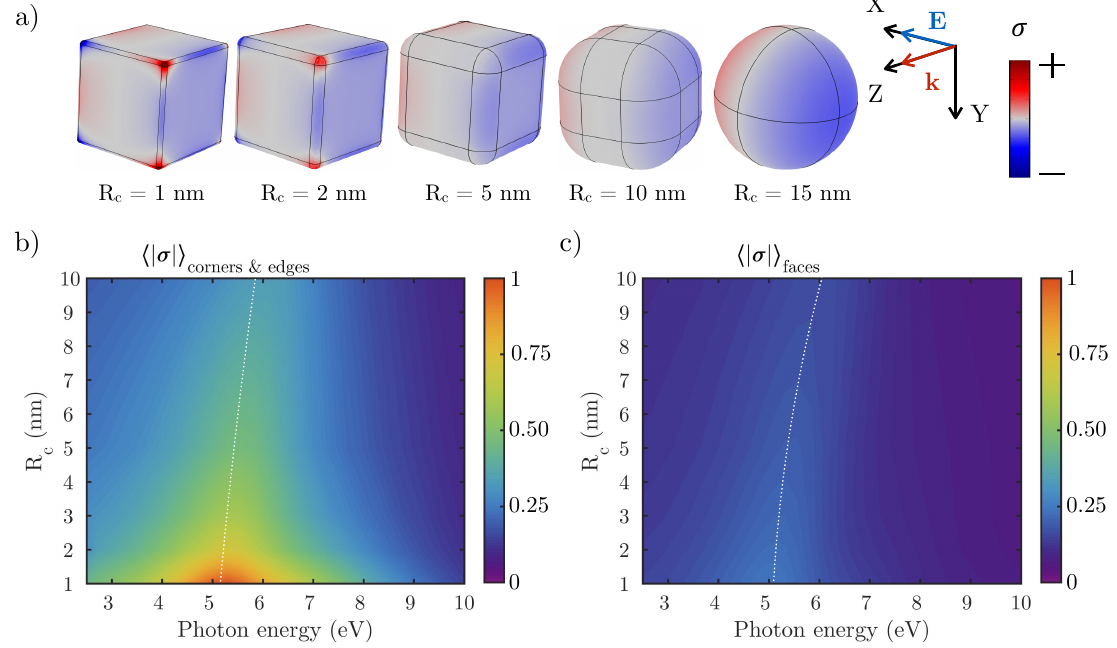
Figure 6. ( a ) surface charge distribution ( σ ) over Rh NCs with rounded edges and tips with a curvature radii R c when illuminated at the resonant wavelength. The red/blue regions represent positive/negative charge densities; ( b ) normalized values of σ averaged over the edges and corners; and ( c ) over the flat faces of the